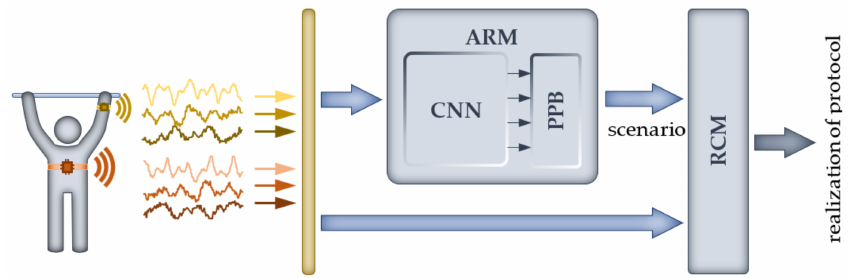
Figure 4. The scheme of the validation